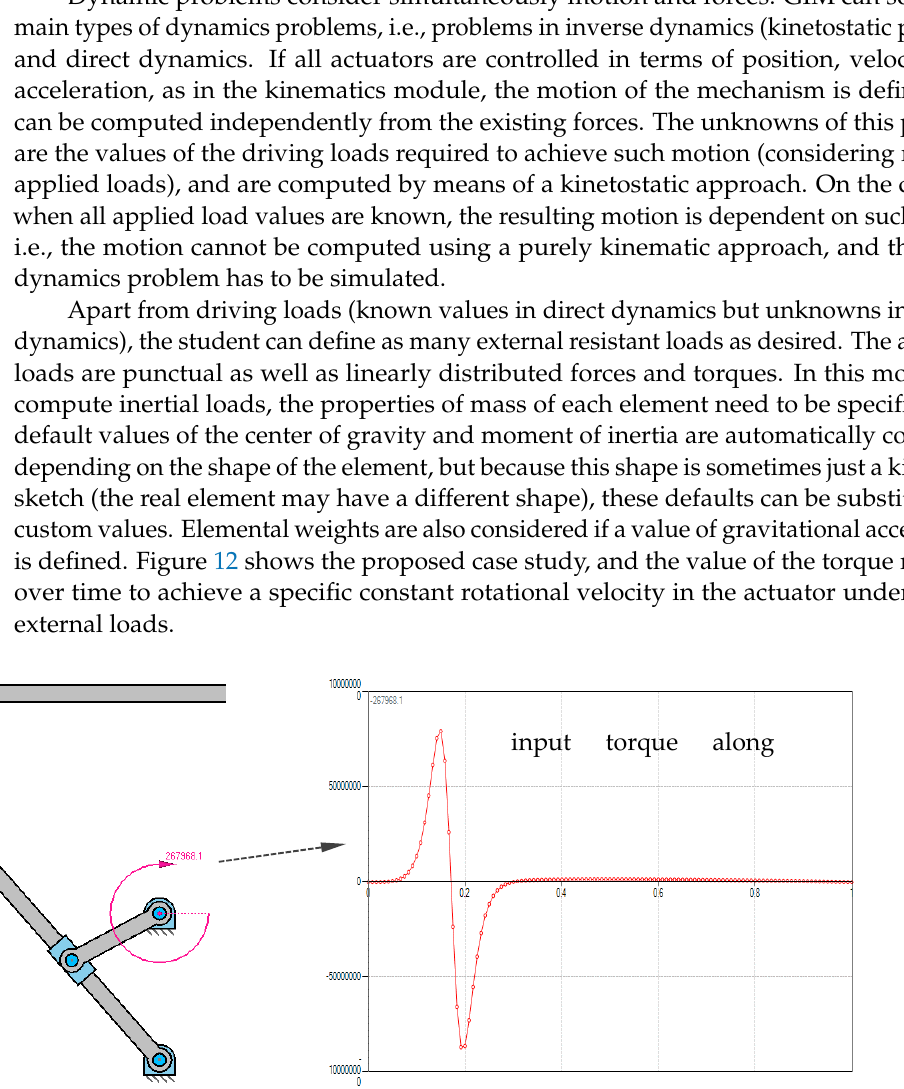
Figure 12. Value of driving load for the computation of inverse dynamics.